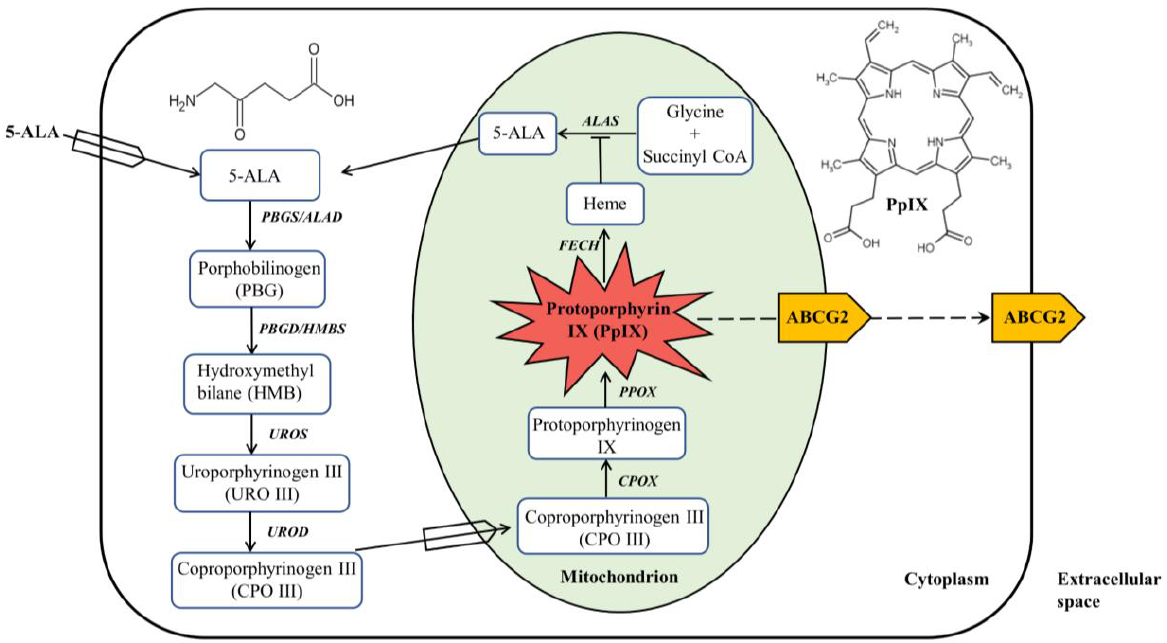
Figure 1. ALA-mediated PpIX biosynthesis in the heme biosynthesis pathway. ALA administered exogenously is metabolized in the heme biosynthesis pathway, which is composed of four enzymes in the cytoplasm and four enzymes in the mitochondrion, to produce PpIX with red fluorescence and photosensitizing activity. PpIX can be converted to heme with no fluorescence and photosensitizing property or effluxed out via primarily ABCG2